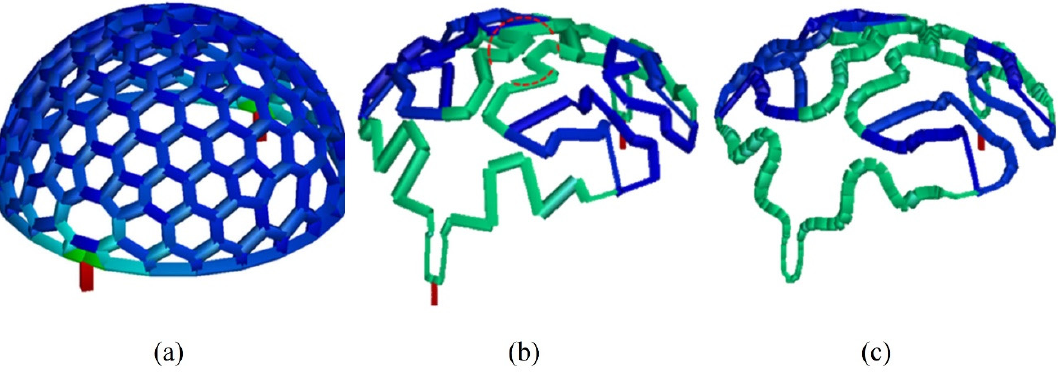
Figure 11. Cooling channels design in the mold cavity: ( a ) initial design, ( b ) optimal design, ( c ) smoothened design of the CCCs. Adapted with permission from [36], 2017, Li et al. [36].